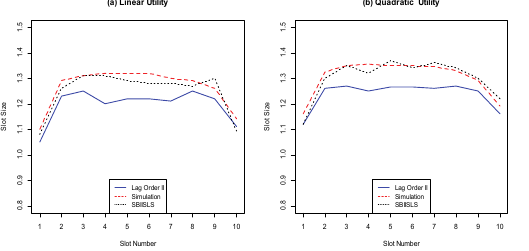
Fig. 3 Optimal lot size for SBKSLS compared with lag order method and simulation. (cid:1840) (cid:3404) 11 , Weibull distributed service times with mean 1 and CV=0.5